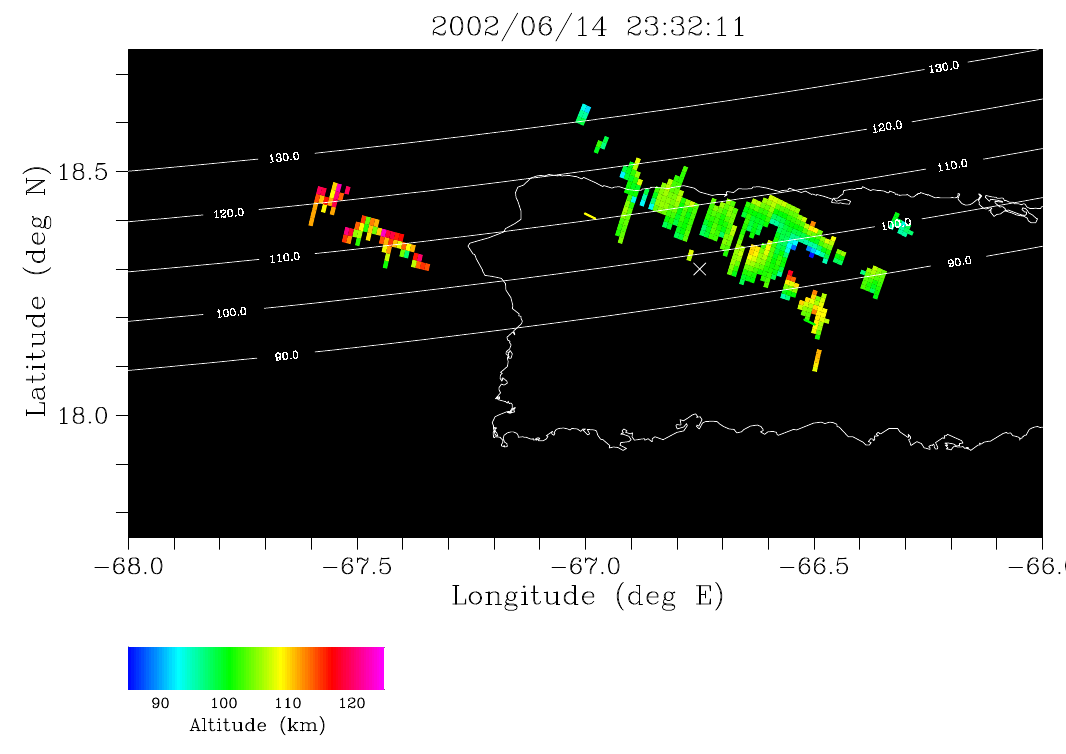
Fig. 10. False-color representation of the centroid altitude of the backscatter shown in the previous figure.